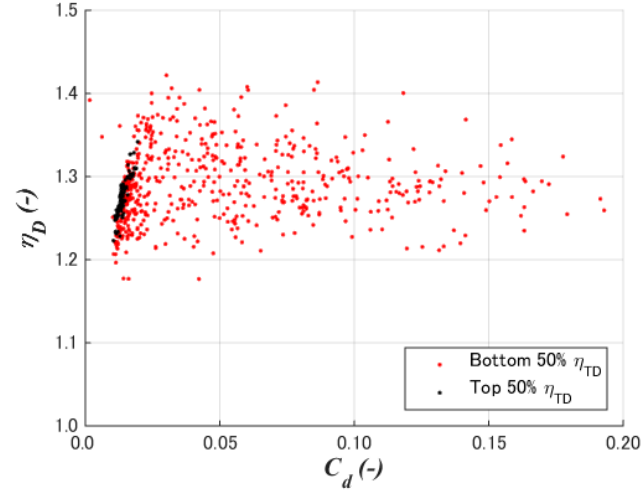
Figure 9. Diffuser efficiency to drag coefficient .